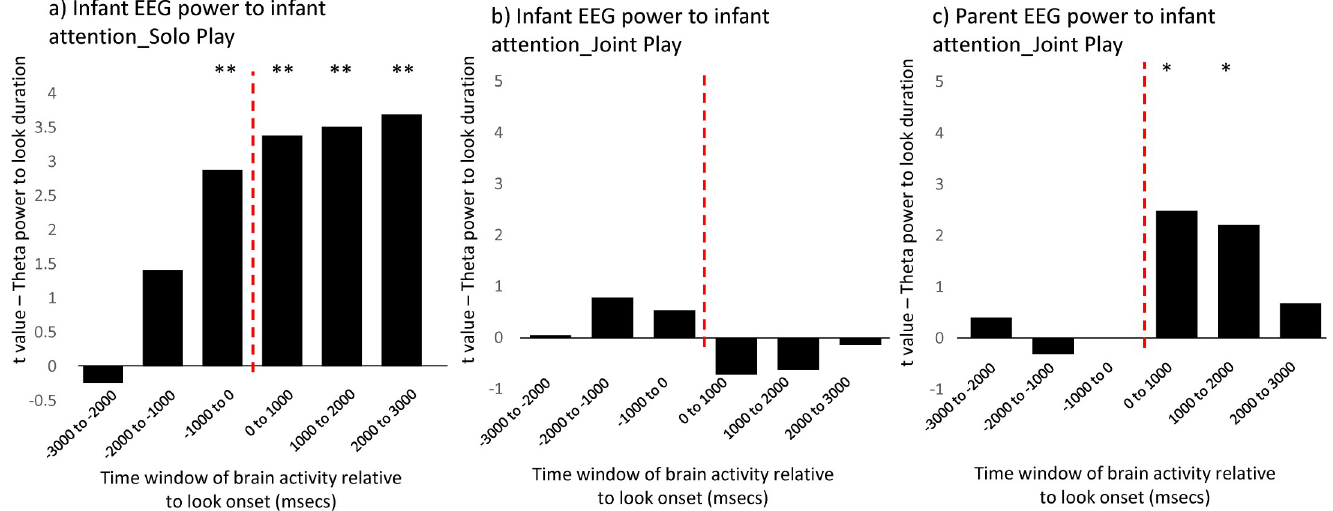
Fig 6. Analysis 3 results. Results of linear mixed effects models conducted to examine whether individual looks accompanied by higher theta power are longer lasting. For each look, the theta power for three time windows prior to look onset (3,000–2,000, 2,000–1,000, and 1,000–0 ms pre-look) and for three time windows post look onset (0–1,000, 1,000–2,000, and 2,000–3,000 ms post-look) was excerpted. We then calculated separate linear mixed effects models for each of the six windows to examine the relationship between EEG power within that time window and look duration. y-axis shows the t value. � indicates the p values ( � p < 0.05, �� p < 0.01). Full results are shown in S1 Table. The underlying data for this figure can be found in S1 Text and S1 Data.